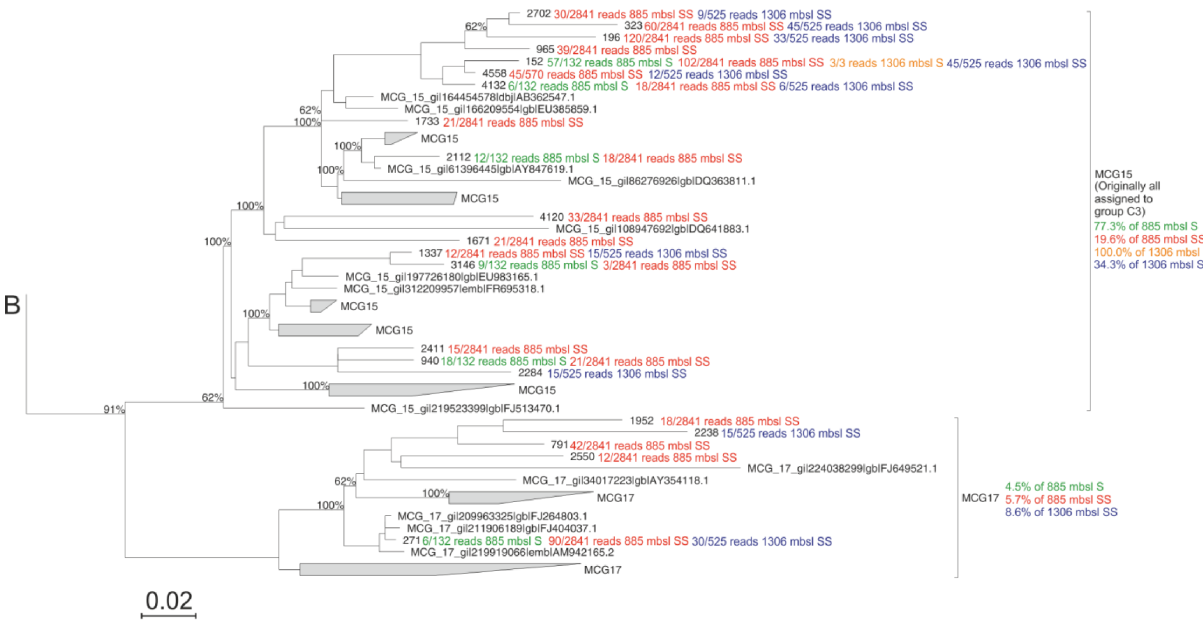
Figure 2. Maximum likelihood phylogenetic tree of the archaeal groups MCG and C3 (modified from Fillol et al., 2015). Extracted OTUs from the Arabian Sea sediments assigned as MCG were inserted in the tree. The number of detected reads per OTU per sample are indicated. Per MCG subgroup the relative abundance is given as detected at the different stations and sediment depths; this is also noted in Table 4. The scale bar represents a 2% sequence dissimilarity.